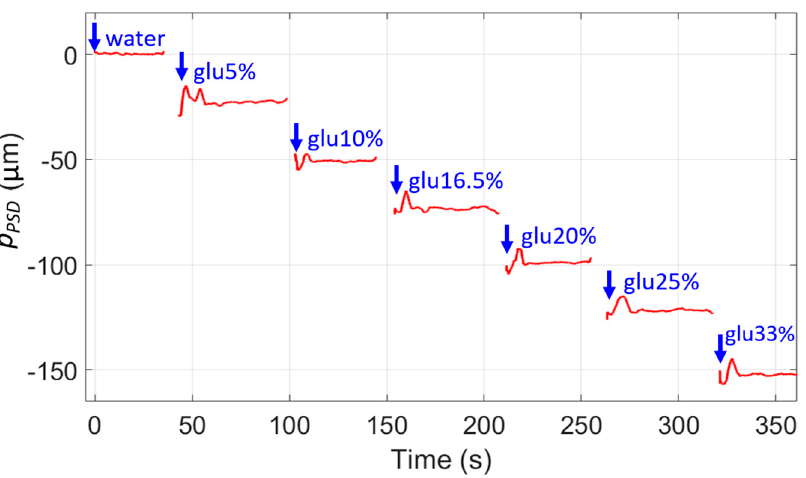
Figure 3. Variation of the beam position p PSD detected by the PSD as a function of time when water and water–glucose solutions with different concentrations are tested.